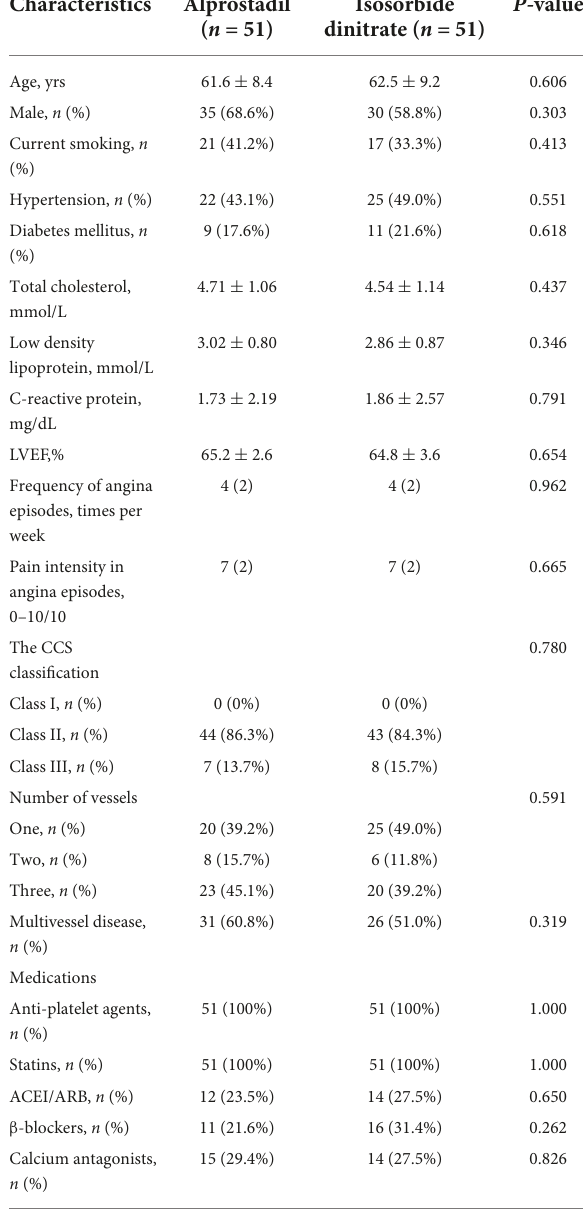
TABLE 1 Clinical characteristics and coronary angiographic findings of all patients.